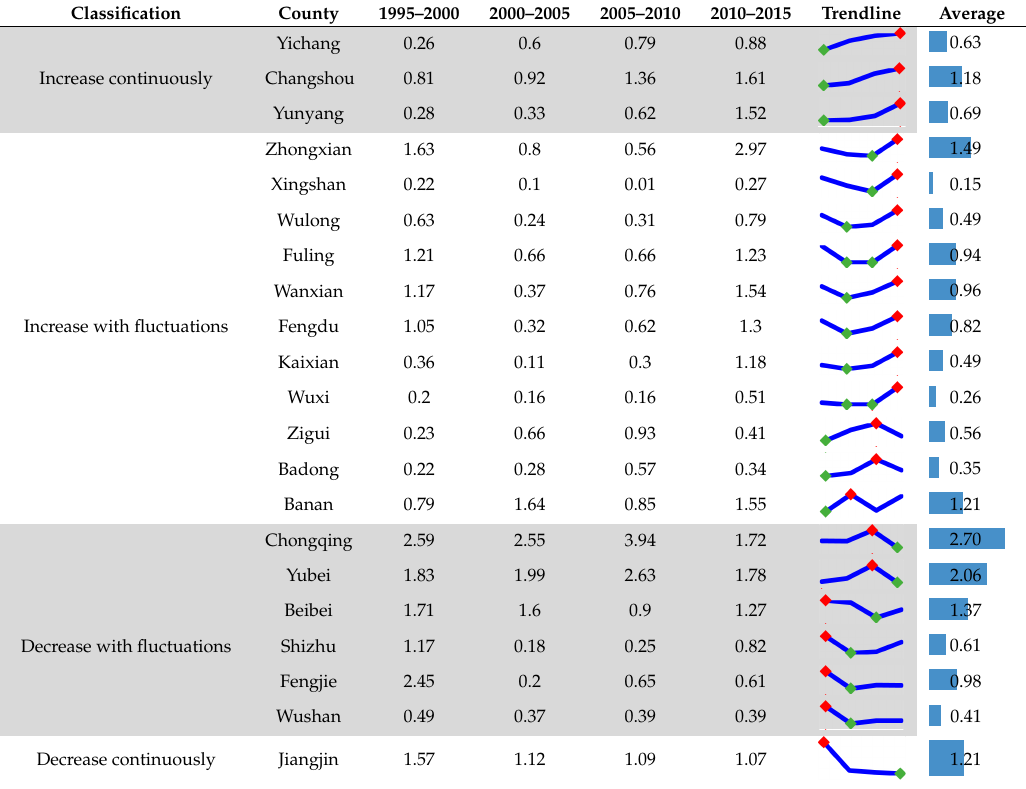
Table 3. Averaged sensitivity index of SCSV (soil conservation service value) change in response to land use/cover change in each county of the Three Gorges Reservoir Area for the four construction periods. The green and red points in the trend line denote the minimum and maximum sensitivities,